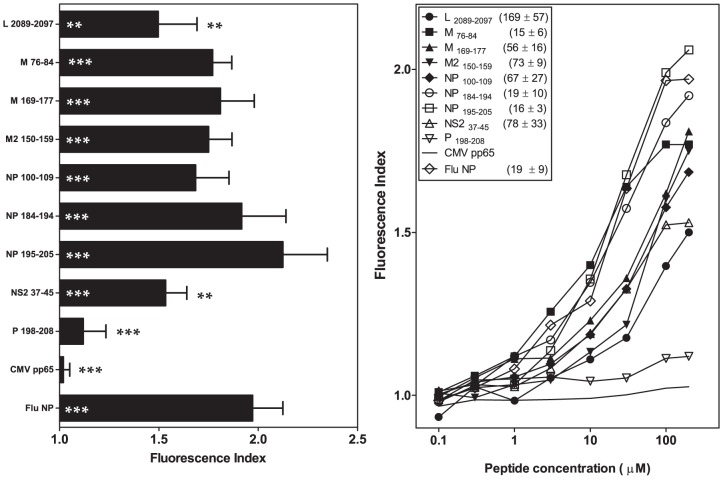
HLA-B*2704 stabilization with synthetic HRSV ligands.The stability of HLA-B*2704/peptide complexes on the cell surface of transfected RMA-S cells was measured through flow cytometry. The results shown in left and right panels are depicted as in Fig. 1A and 2B, respectively, showing the mean values obtained from three or four independent experiments.